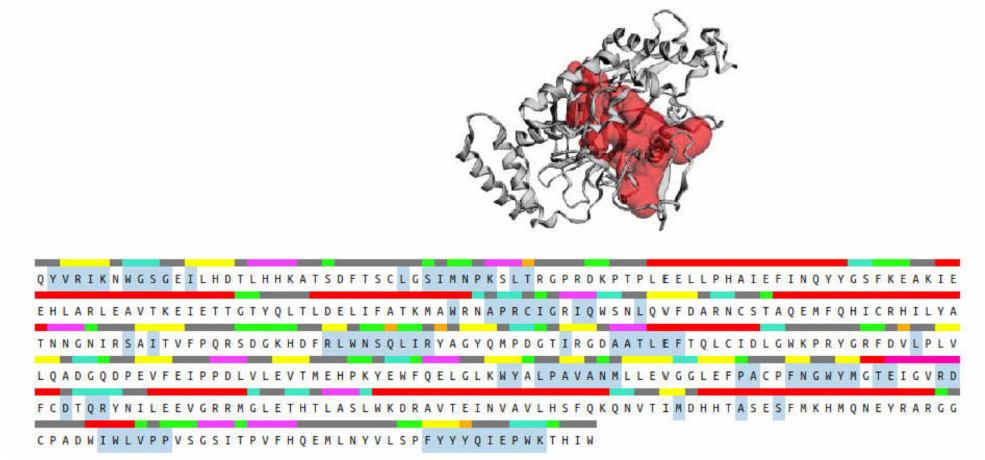
Figure 14. Binding pocket (red color) from the CASTp 3.0 tool, along with the sequence showing the residues highlighted in blue that form the binding